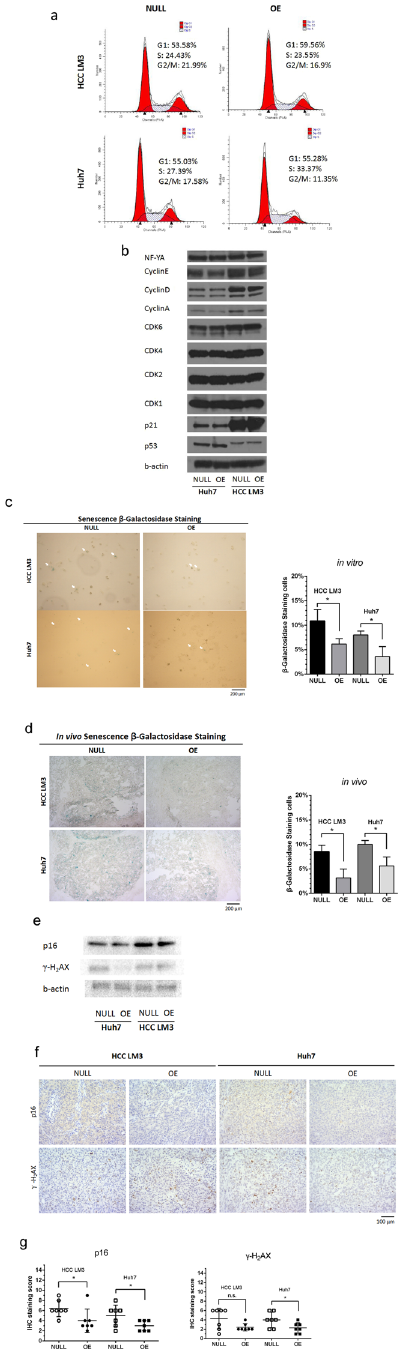
Figure 4. PANDA contributes to tumor growth by inhibiting senescence. ( a ) Representative pictures of cell cycle analysis show that there are no significant difference of G1/S transition between PANDA-overexpressing cells (OE) and control cells (NULL). ( b ) Cell cycle related proteins in both NULL and OE groups were detected by western blots. The corresponding full-length blots were exhibited in Supplementary Figure 1. ( c ) In vitro cultured cells stained with senescence associated β -galactosidase in both groups were presented and analyzed statistically. ( d ) In vivo xenograft tumor samples stained with senescence associated β -galactosidase in both groups were presented and analyzed statistically. ( e ) Senescence markers p16 and γ -H 2 AX were detected by western blots in indicated cells. The corresponding full-length blots were exhibited in Supplementary Figure 2. ( f ) Senescence markers p16 and γ -H 2 AX were detected by IHC in indicated xenograft tumor samples. ( g ) IHC staining scores were